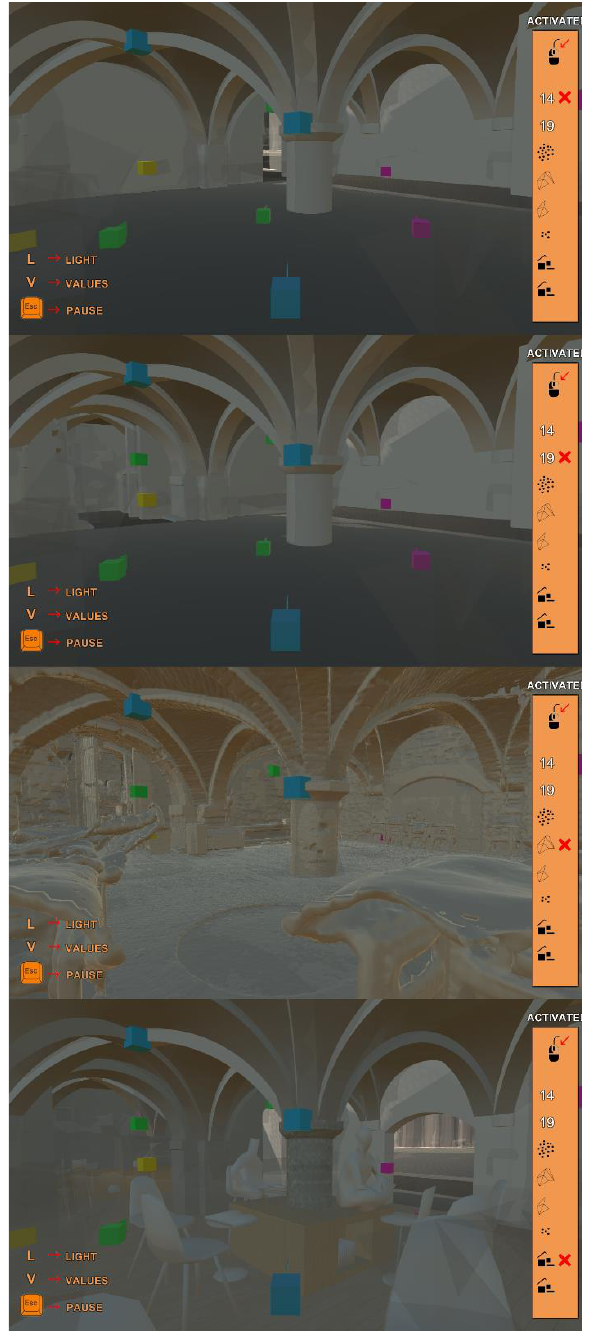
Figure 13. Representation of multiple states of existence of the crypt in the virtual environment. The image successively depicts two reconstitutions of previous states (14 th & 19 th century), the present state and finally, the project.